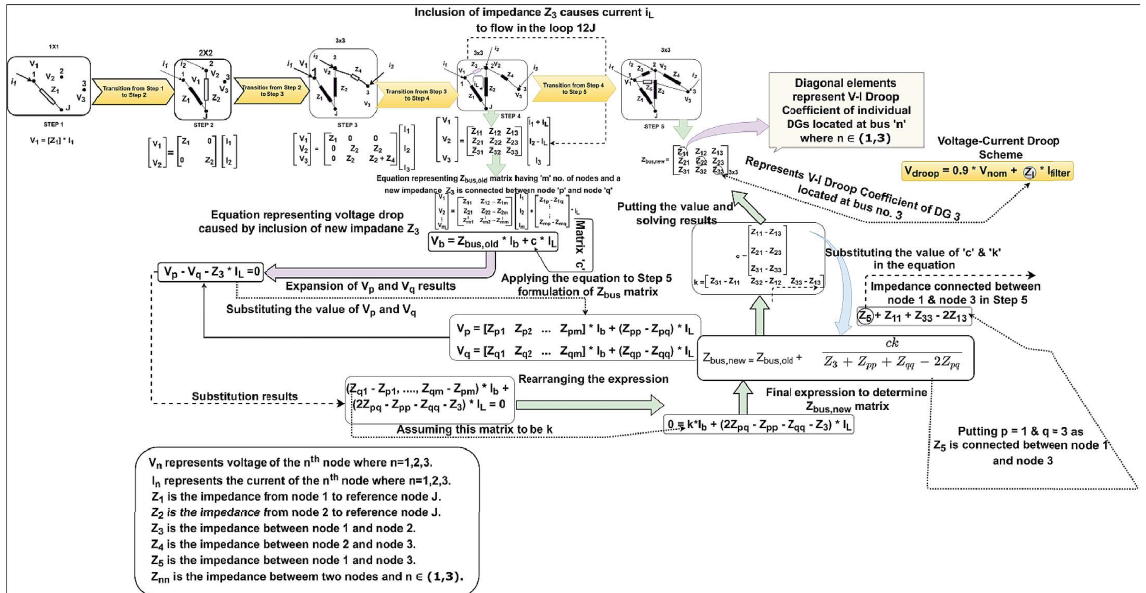
Figure 4: Voltage-current droop coefcient estimation